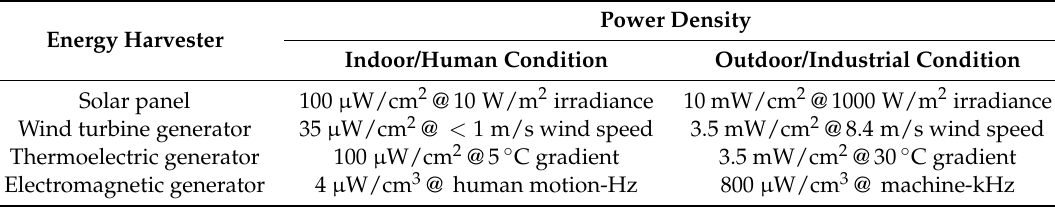
Table 2. Performance of energy harvesters